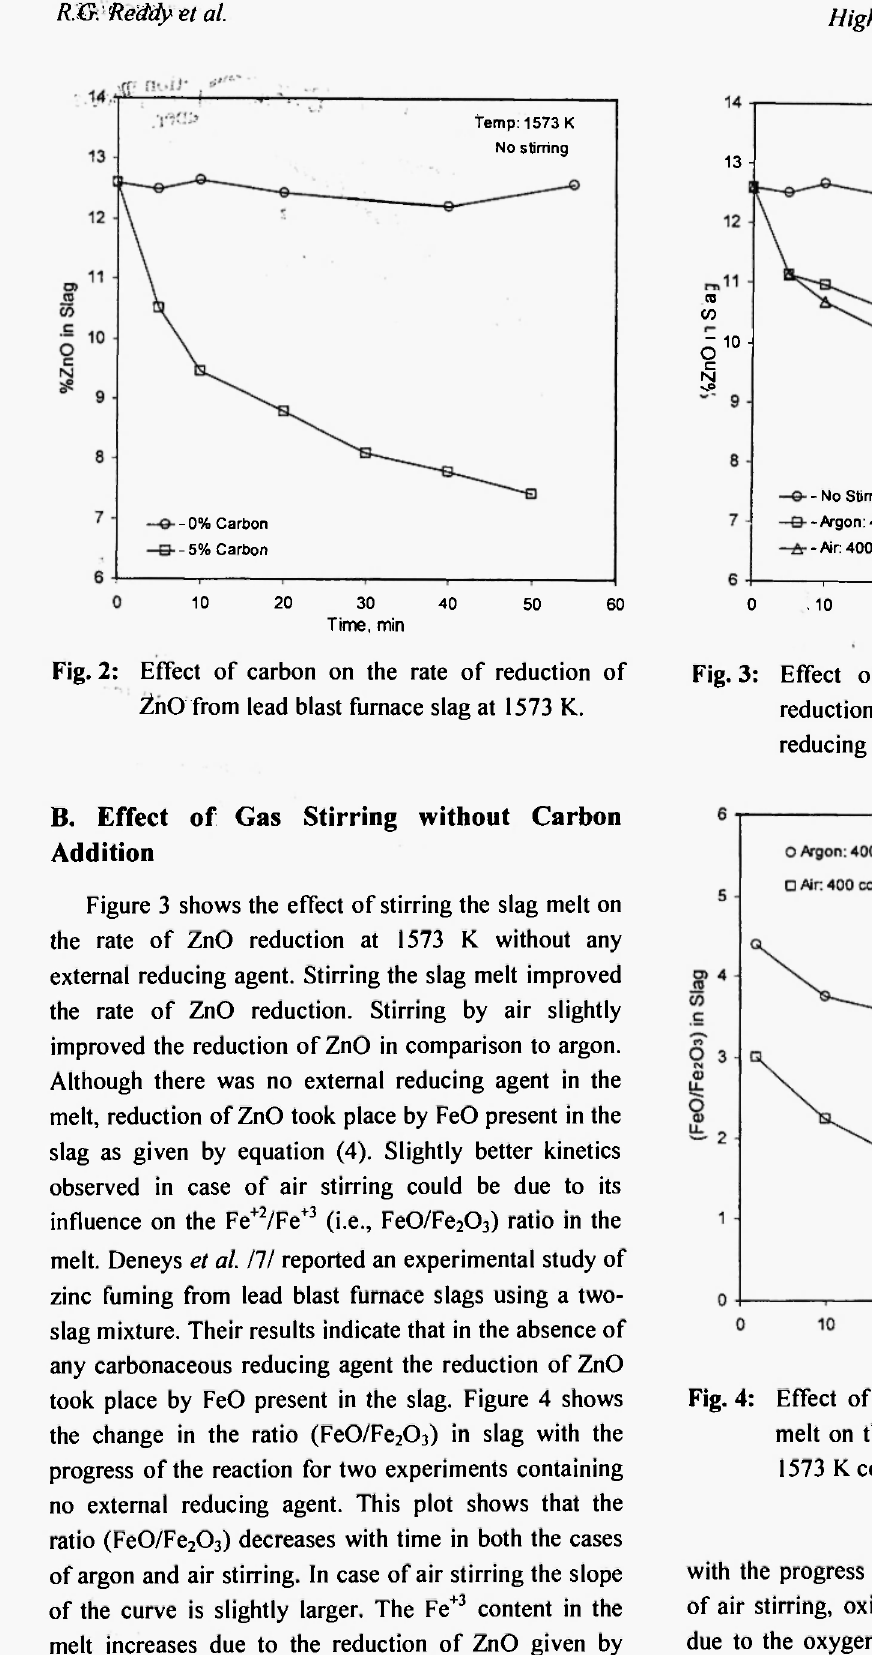
Fig. 4: Effect of the type of gas used for stirring the melt on the ratio of (Fe0/Fe 2 0 3 ) in the slag at 1573 Κ containing no carbon in the